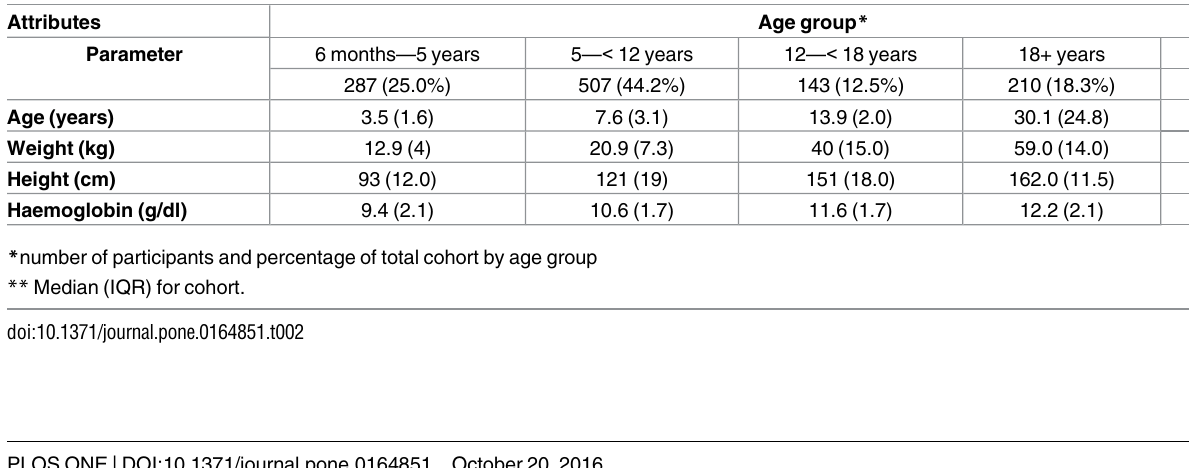
Table 2. Clinical and demographic background of study participants. Data presentedare Medianand InterquartileRange (IQR) for each measurement.